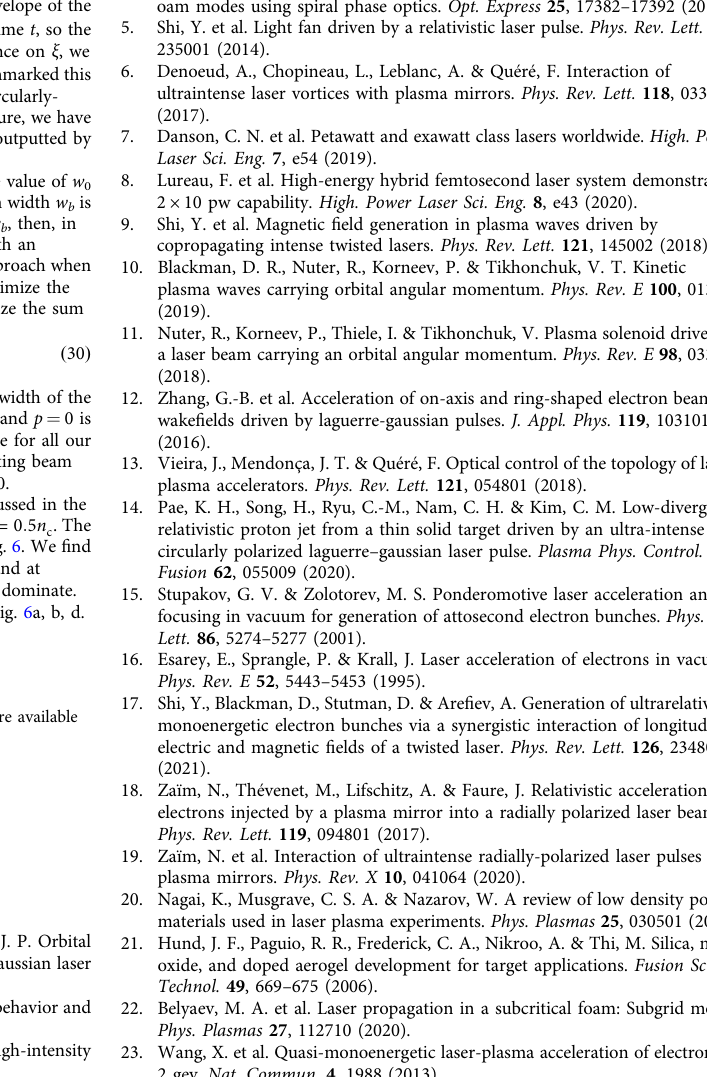
Fig. 6 Mode decomposition. a Amplitudes of different radial modes for B H z in Fig. 3a obtained via Eq. ((29)). b Amplitudes of different radial modes for B H z in Fig. 3d obtained via Eq. (29). c The sum of mode amplitudes is de fi ned by Eq. (30) as a function of w 0 mode decomposition. The crosses mark the values that are used in ( a ) and ( b ) to compute the mode amplitudes. The solid and dashed curves correspond to the targets with n max ¼ 2 : 5 n c and n max ¼ 0 : 5 n c , respectively. d Mode amplitudes at the axial location marked with a dashed line in ( a ) and ( b